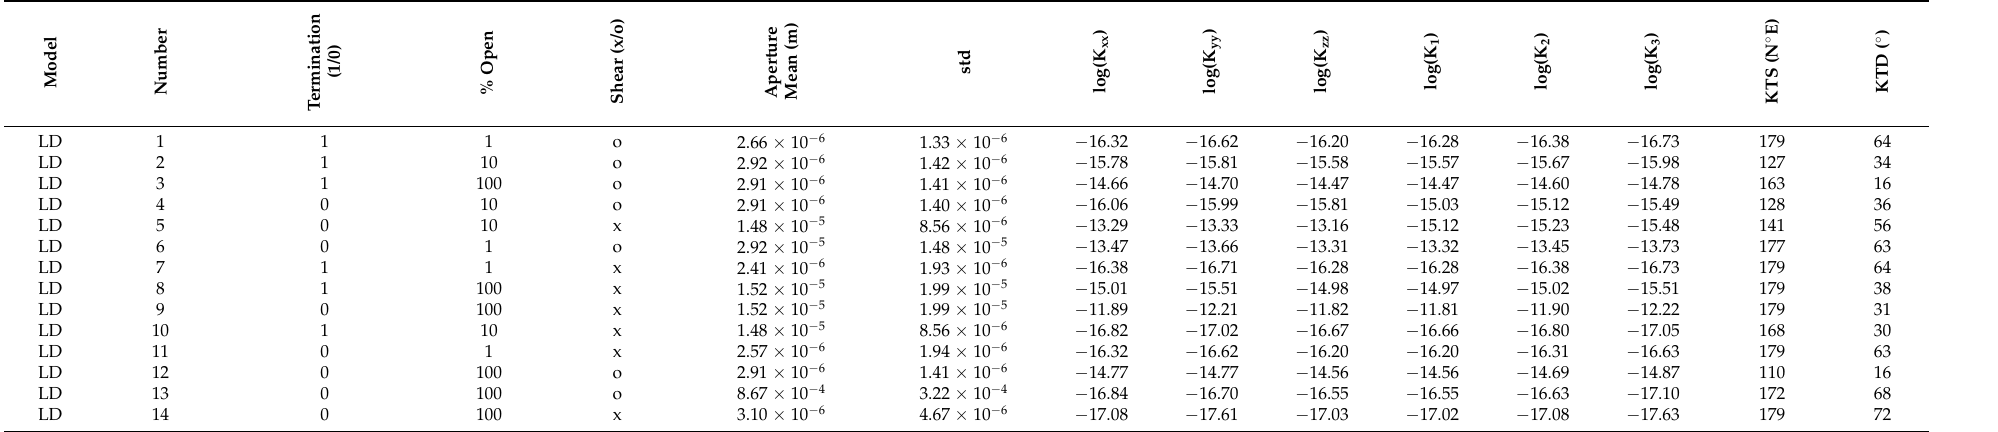
Table 6. Case 1 DFN models; aperture and permeability tensor distribution, with K xx , K yy and K zz and permeability tensor magnitudes (K 1 , K 2 and K 3 ), as well as main tensor orientation (KTS, strike and KTD, dip).